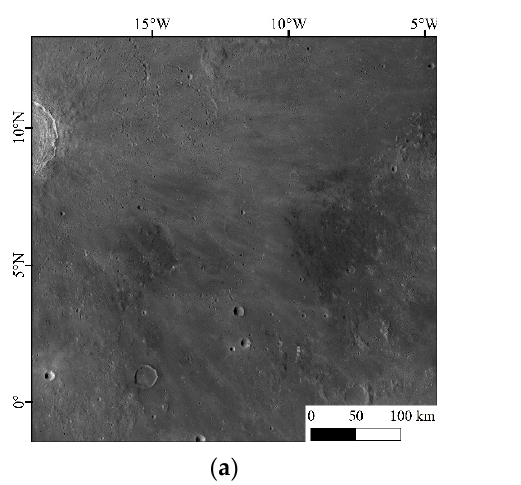
( b ) Figure 15. Olivine-bearing exposure in the northern wall of Copernicus. ( a ) Olivine-bearing expo- sure shown on the CE2 DOM G122; ( b ) Olivine map of the exposure.